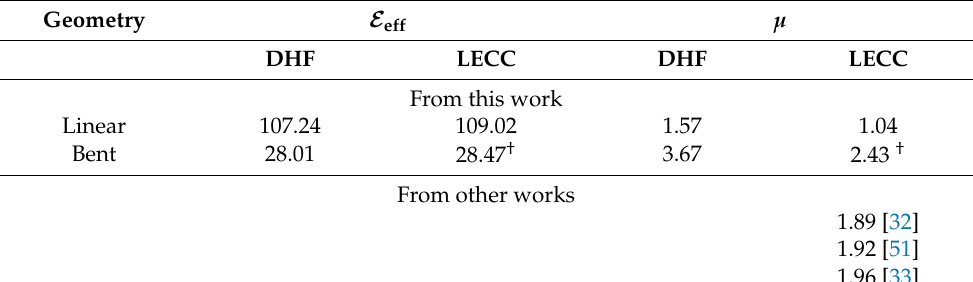
Figure 2. The extrapolation scheme from a linear to a bent geometry, for the permanent electric dipole moment (PDM) of HgOH. The data points in blue show the finite-field coupled-cluster (FFCC) values of the PDM in a non-relativistic framework, while for those in red, the point corresponding to the linear geometry is calculated, and the one pertaining to the bent geometry is the extrapolated value. We add that the distance that we have set between the points corresponding to the linear and bent geometries on the X-axis is arbitrary. Table 2. Table showing the calculated E eff (in GV/cm) and µ (in D) values in HgOH by assuming its hypothetical linear and the actual bent geometry ground state using the Dirac–Hartree–Fock (DHF) and RCCSD methods. We also give µ values from the previous calculations using density functional theory